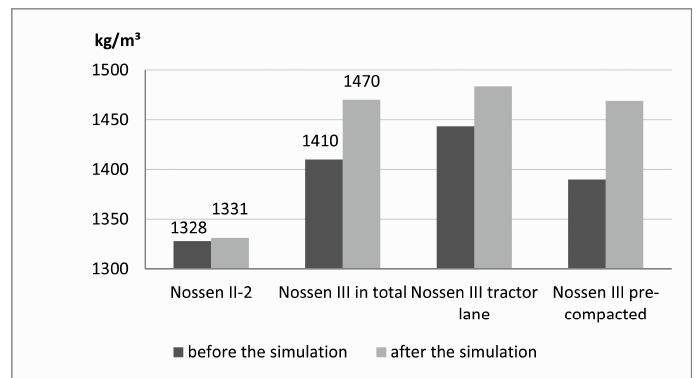
Table 2. The total runoff, runoff coefficient and soil loss per